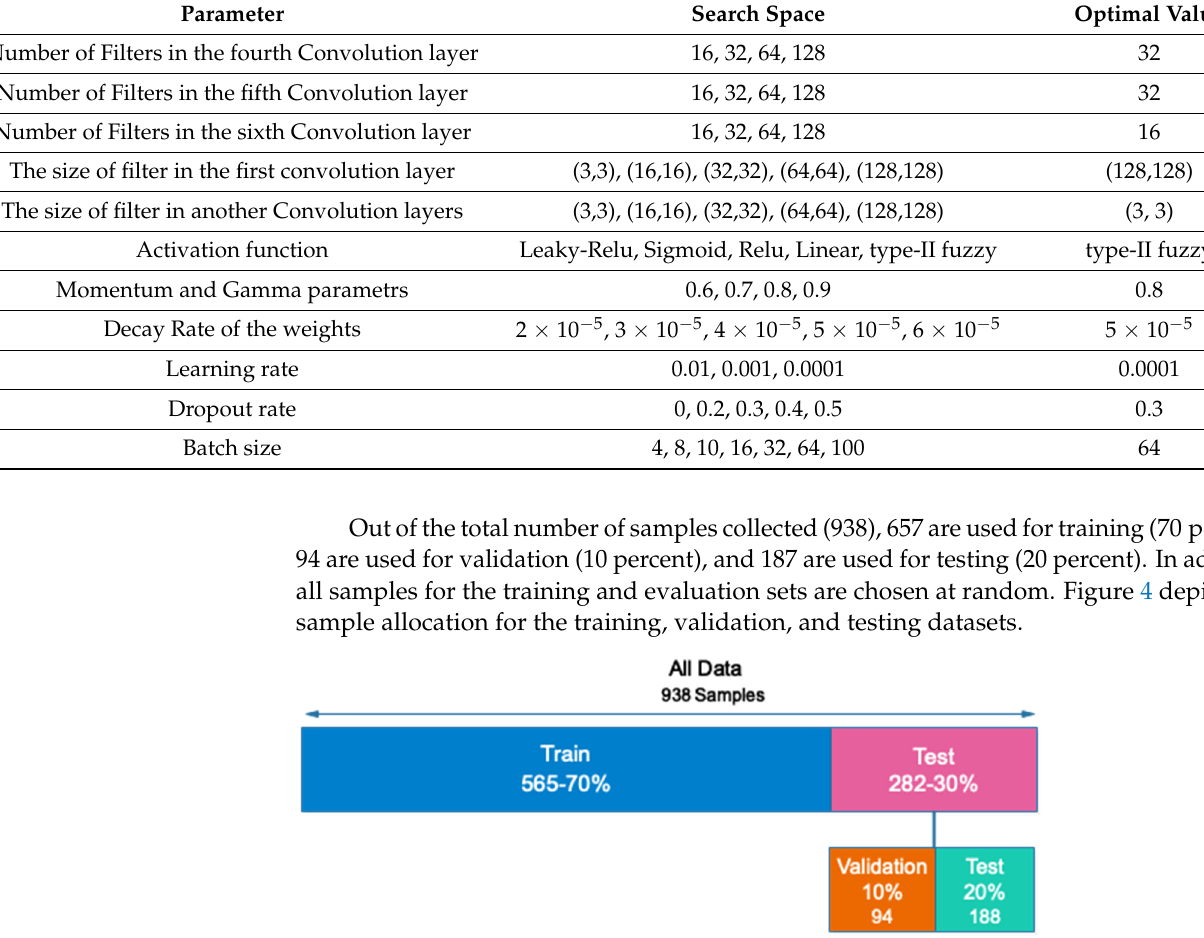
Figure 4. Allocation of data to evaluate the proposed network.